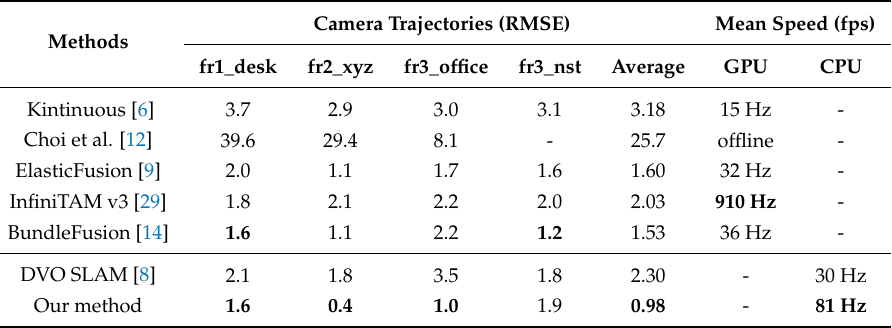
Figure 7. Comparison of the reconstruction results on real-world scenes. Fr3_snt_far and fr3_snt_near are manually scanned with the Asus Xtion sensor. Corridor and room are scanned through a robot equipped with Microsoft Kinect. Table 6. Accuracy of the estimated camera trajectories (ATE RMSE in centimeters) and mean speed (fps) of data fusion on the TUM RGB-D dataset [35]. Bold shows the best